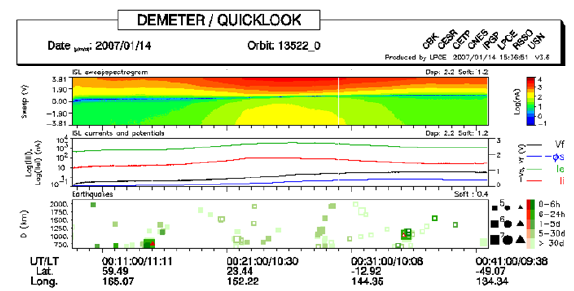
Figure 1a: DEMETER orbit that recorded the anomalous variations eight days afore the seismic event.